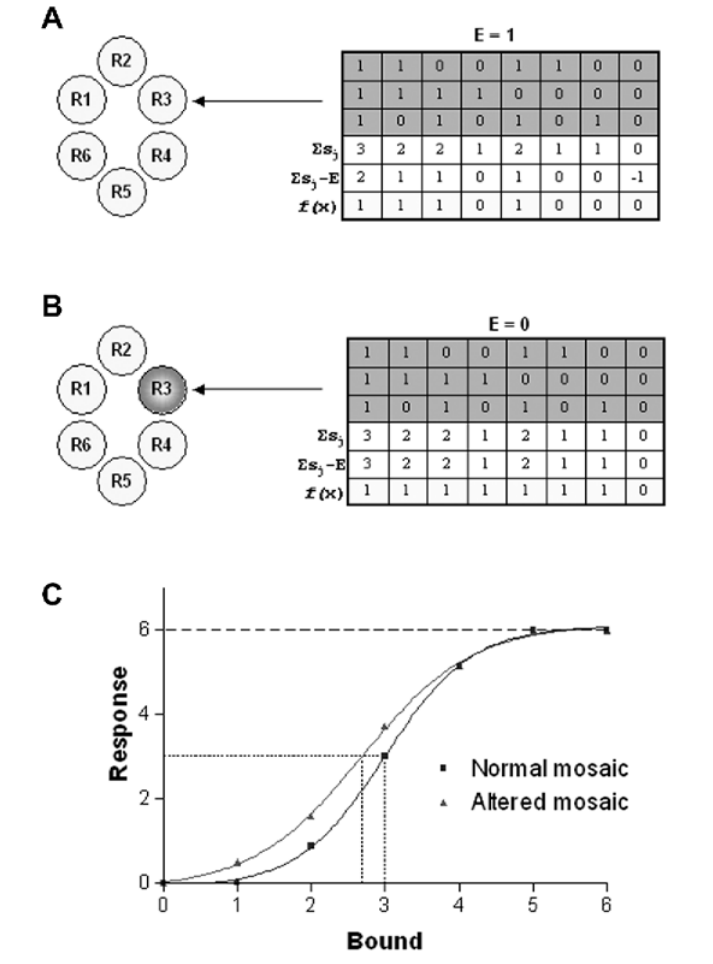
FIGURE 4. Mathematical modeling of a RM consisting of a ring of n = 6 receptors. Each receptor can assume inactive conformations (R states, all coded by 0 and characterized by a “low-affinity state” for the macromolecular effectors) and active conformations (R* states, all coded by 1 and characterized by a “high-affinity state” for the macromolecular effectors). The state( s(t) ) of each receptor evolves in the time as a function of its actual state and of the states of the two nearest neighbors with which it is in contact. A simple boolean function describing the change of receptor state as an effect of its interactions can be written as follows[24,25]: